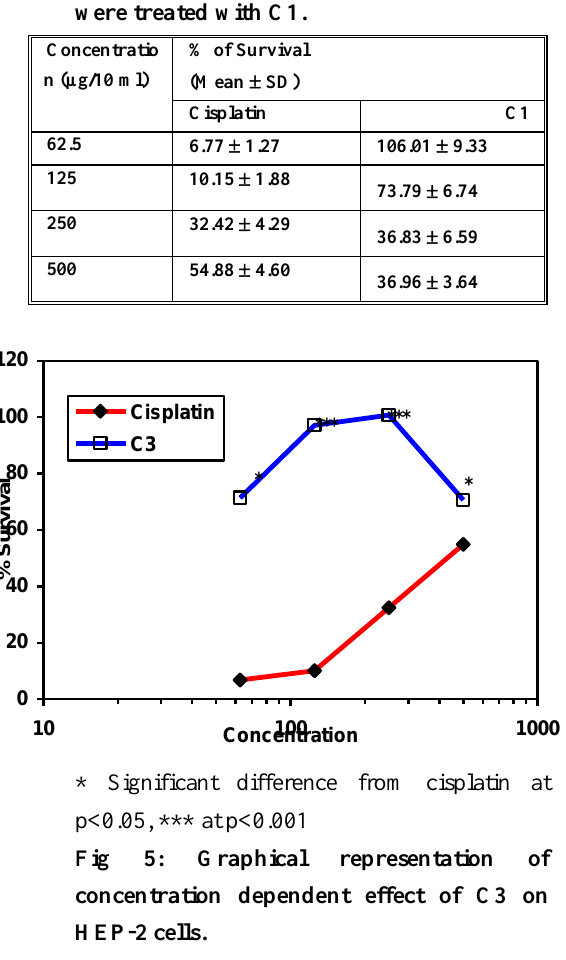
Fig 4: Graphical representation of concentration dependent effect of C1 on HEP-2 cells. Table 1: The cell survival as percentage of the control for the HEP-2 cell when the cells were treated with C1.